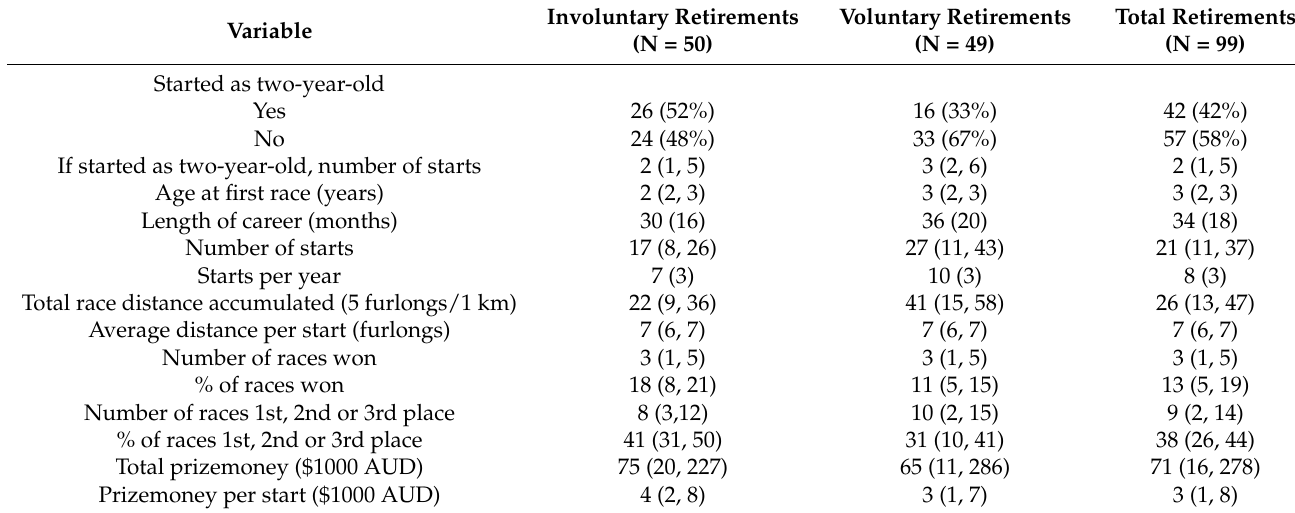
Table 4. The racing career and performance history of 99 retired horses that had raced prior to retirement, stratified by whether retirement was voluntary or